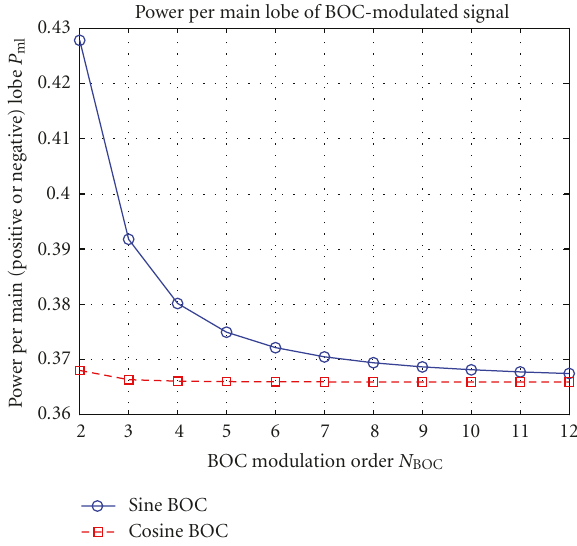
Figure 5: Normalized power per main lobe P ml for BOC-modulated signals for various N BOC